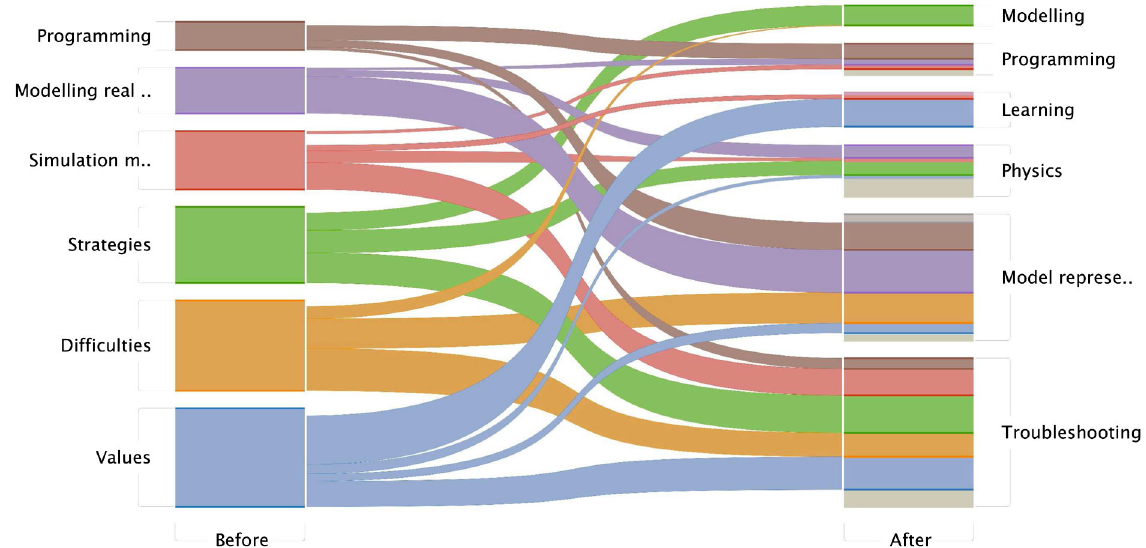
FIG. 5 (color online). Alluvial diagram showing how the modules in the epistemic networks rearrange between before and after the